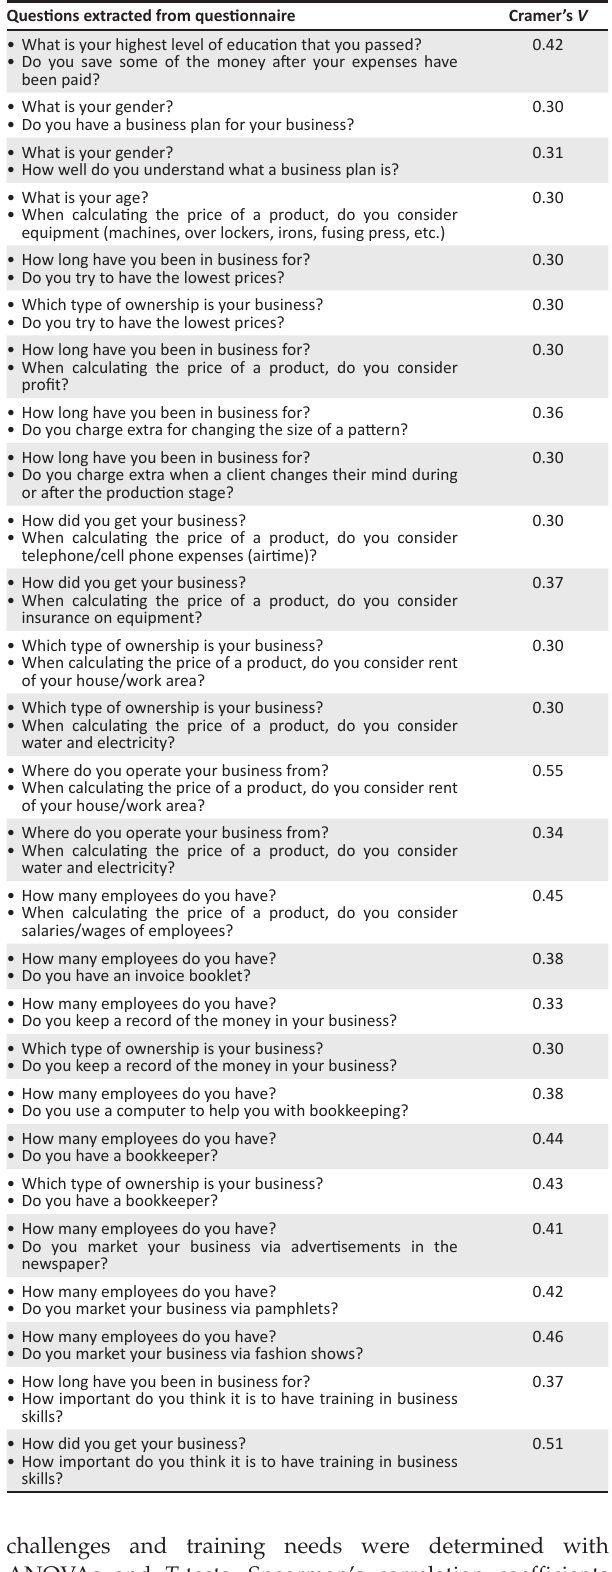
TABLE 3: Individual items in relation to associations between variables. Questions extracted from